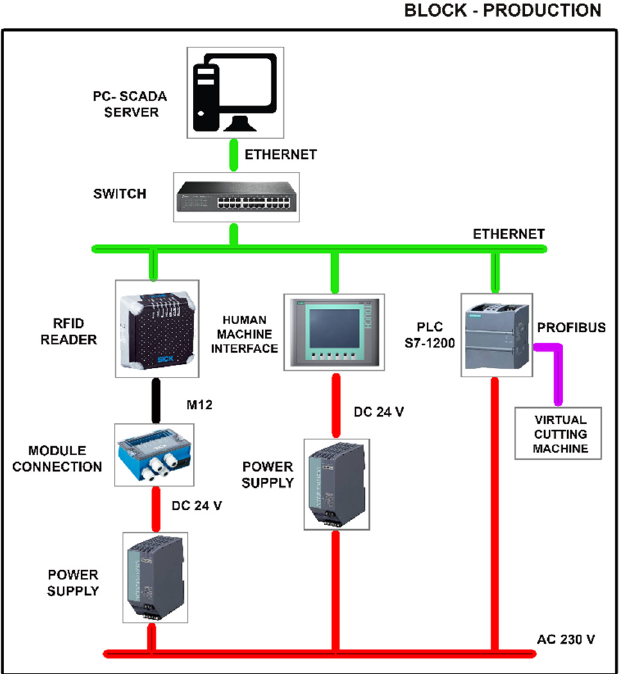
Figure 12. Schematic layout of RFID-System used in the Block-Production Tests.